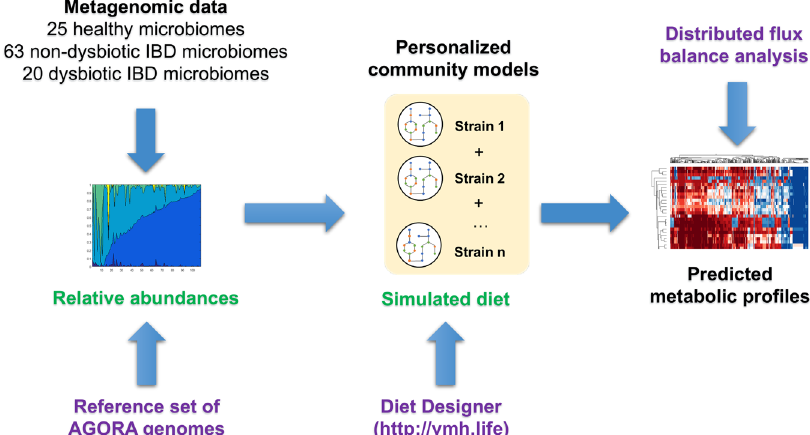
Fig. 1 Schematic overview of the modelling framework established in this study. Metagenomic reads were mapped onto a reference set of AGORA 18 genomes, and the strain-level relative abundances were retrieved. For each metagenomic sample, a personalised microbiome model was constructed. The models were parameterised further with a simulated “ Average European ” diet retrieved from the Virtual Metabolic Human 17 database. The metabolic pro fi le of each microbiome model was then computed with distributed fl ux balance analysis 53 . Required input data are shown in green and required tools are shown in